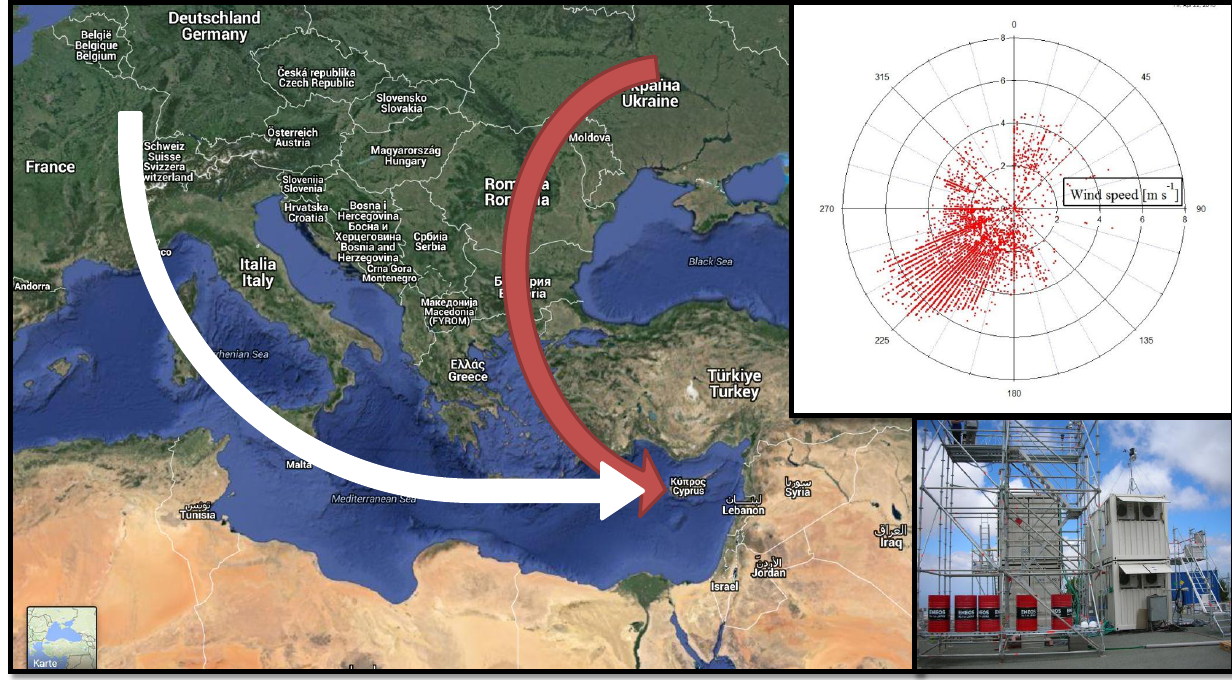
Figure 1. Map of the Mediterranean basin (source: Google). The white arrow shows the inflow from western Europe and the red the inflow from eastern Europe. On the right hand side a wind rose displaying the dominant wind direction and a picture of the laboratory containers can be